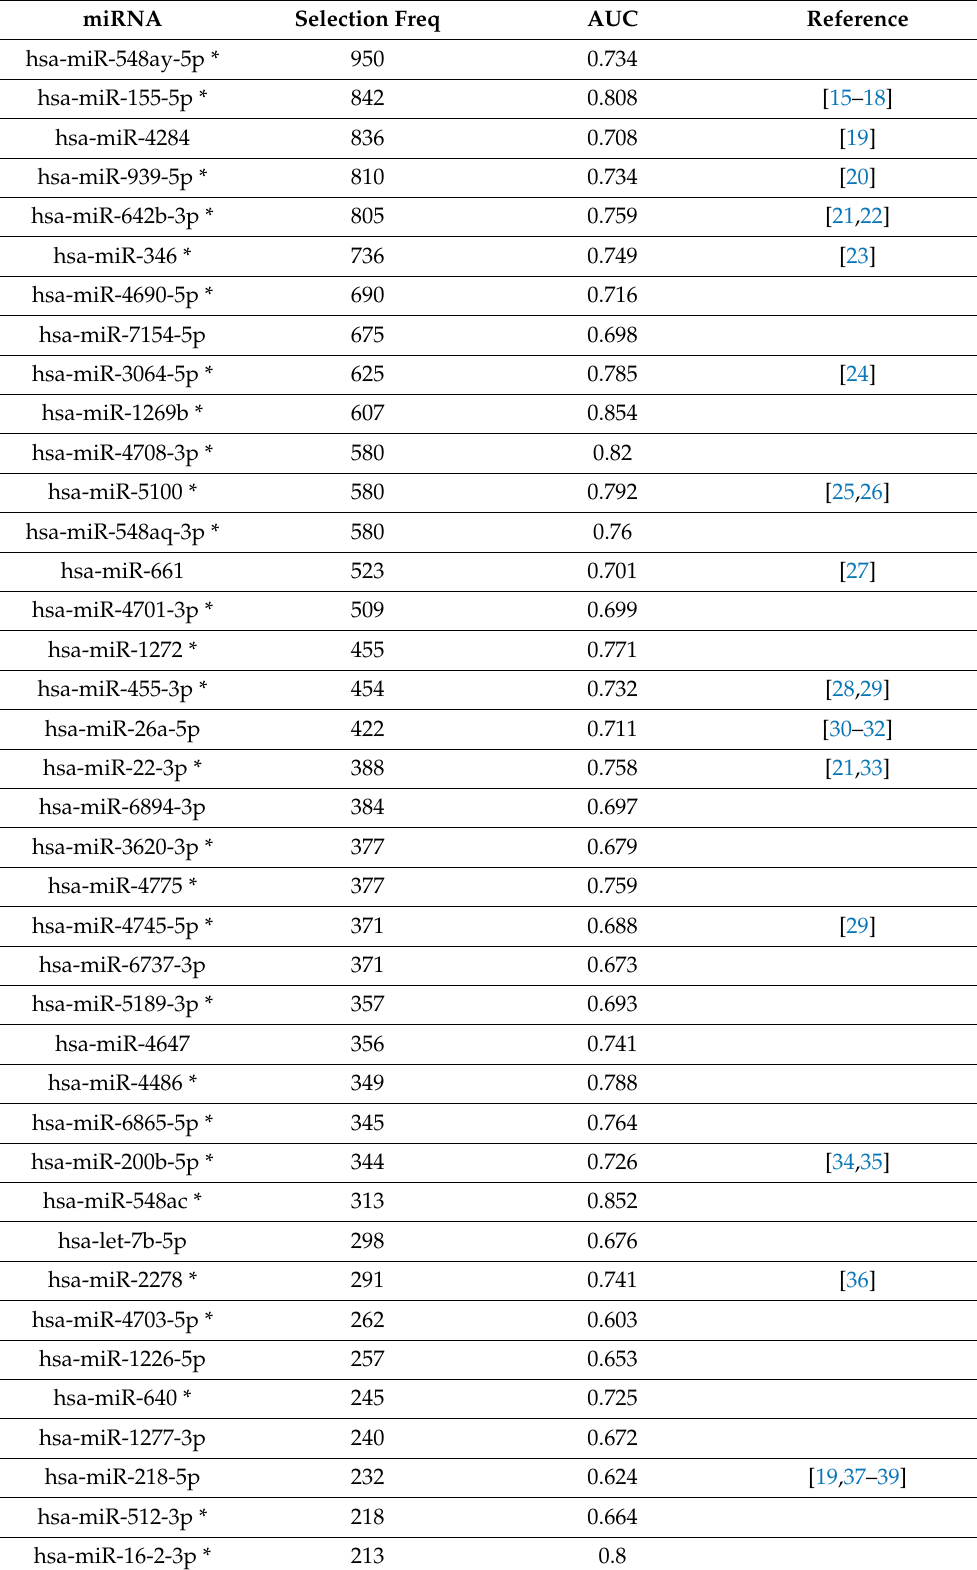
Table 2. The identified 39 PC-specific diagnostic